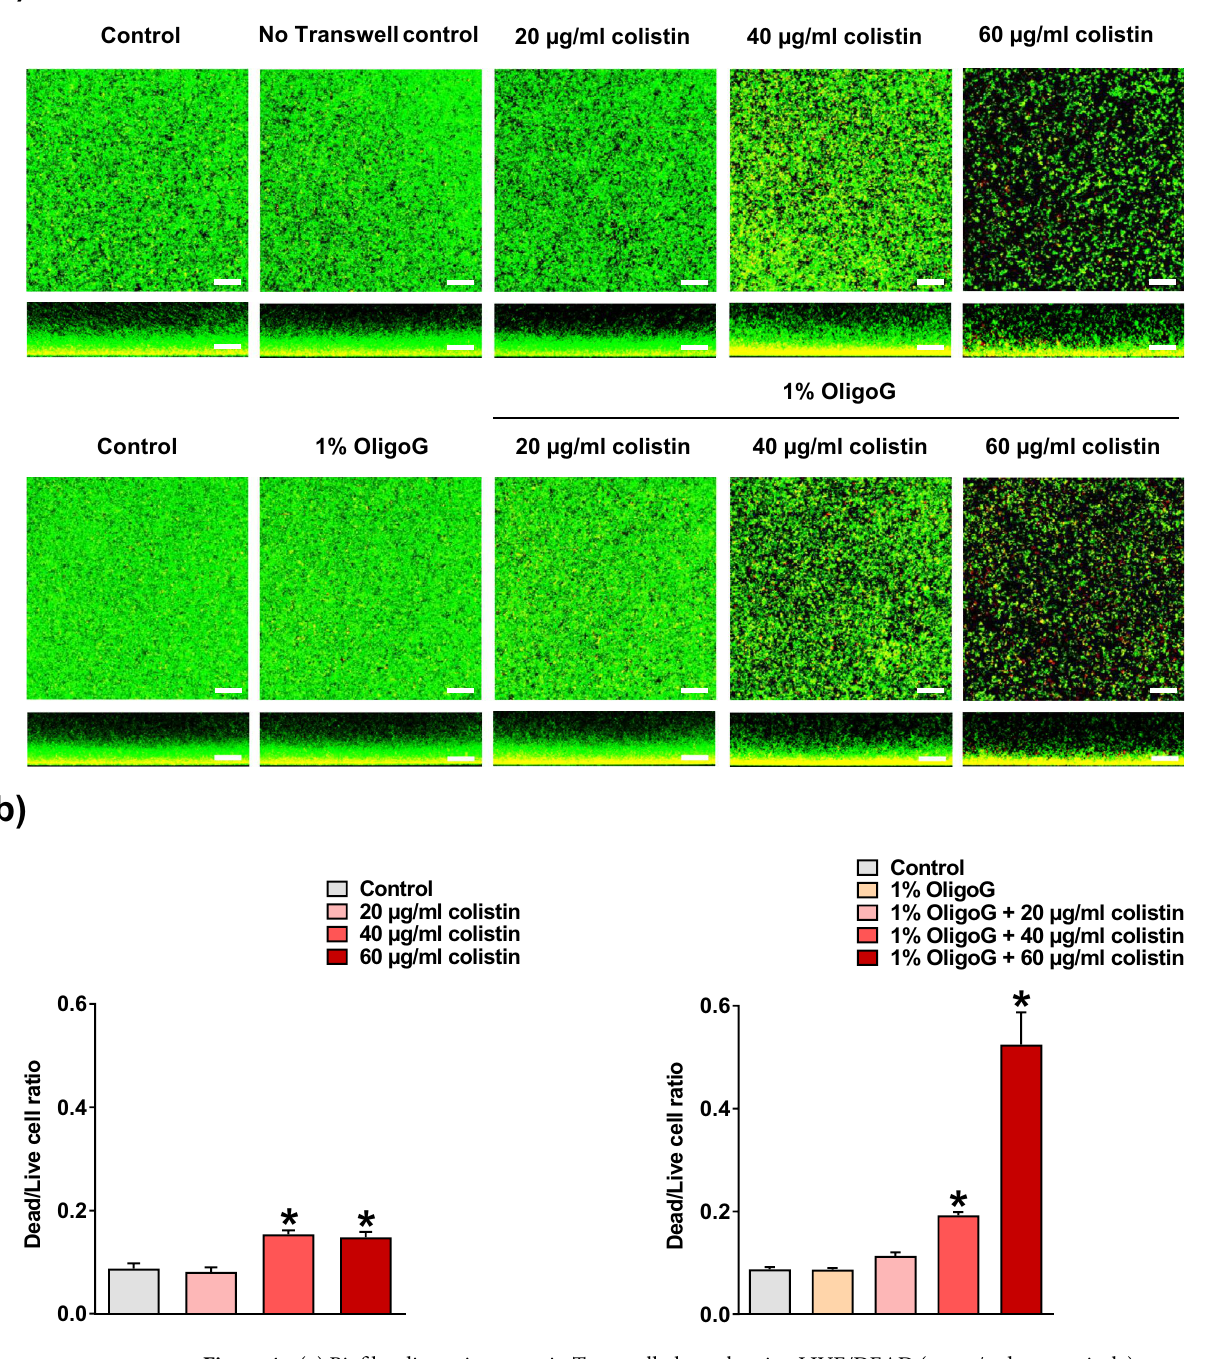
Figure 4. ( a ) Biofilm disruption assay in Transwell plates showing LIVE/DEAD (green/red, respectively) stained confocal laser scanning microscopy (CLSM) images (aerial and cross sectional views, scale bar, 30 μm) of 24 h P. aeruginosa NH57388A biofilms, following 24 h treatment with colistin ± 1% OligoG added onto the artificial sputum medium surface. ( b ) COMSTAT image analysis of the CLSM images (± SEM; n = 15). Significant difference is indicated by *, where * p < 0.05 compared to untreated observed, compared to the untreated control, however, this was not significant for any of the treatment groups. Colistin at 20 µg/ml ± 1% OligoG, or OligoG alone, had no apparent effect on bacterial growth.